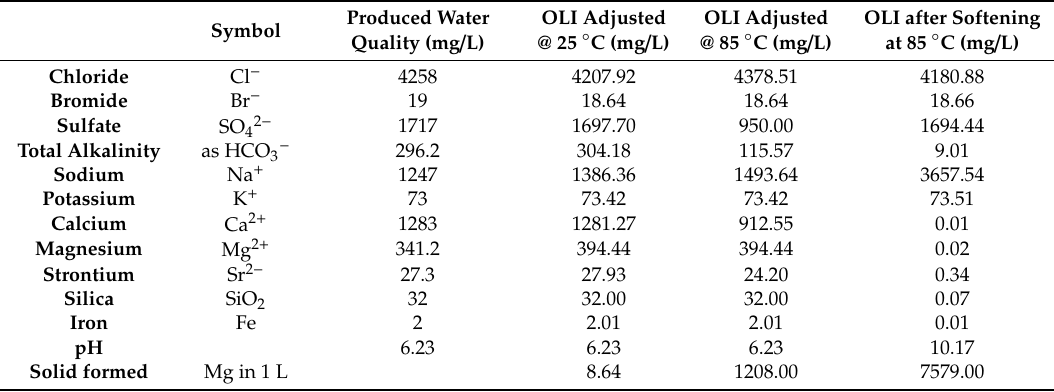
Table 4. Reported and Analyzed Produced Water Quality.